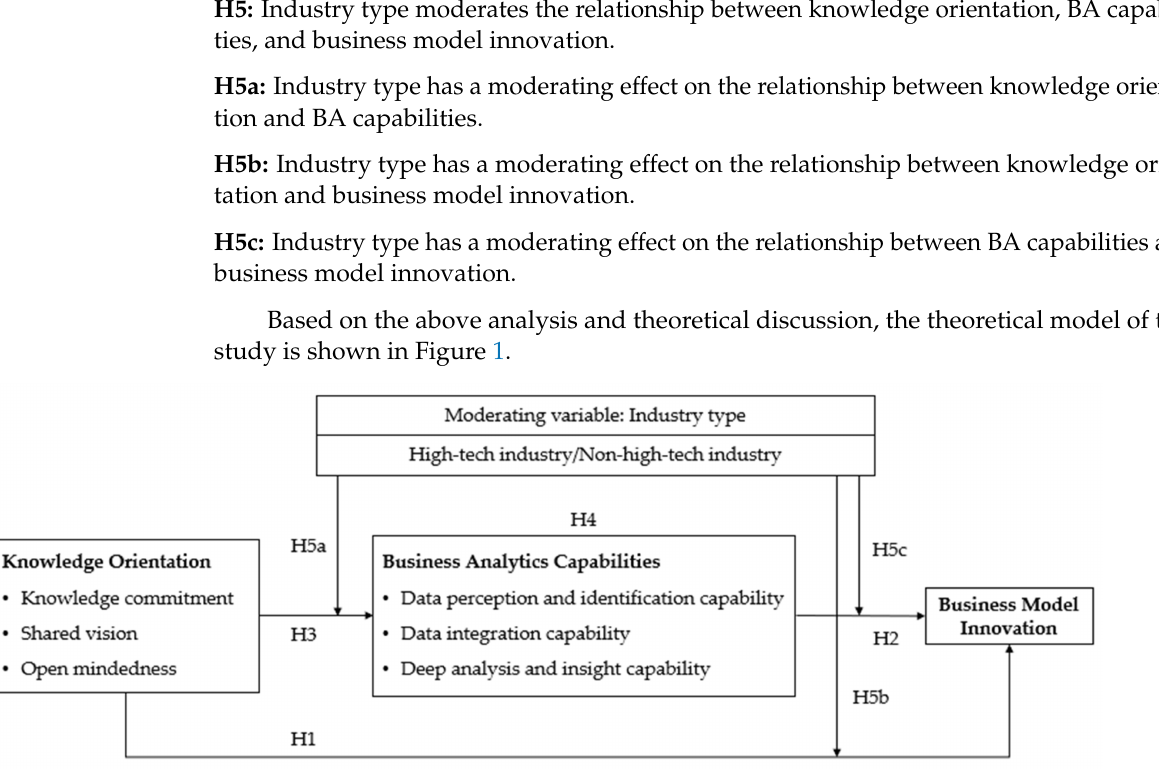
Figure 1. Research